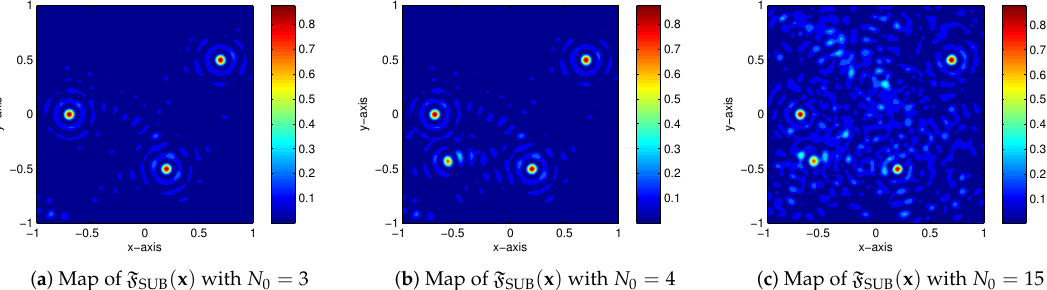
Figure 4. (Example 3: Case 2) Maps of F SUB ( x ) for λ =